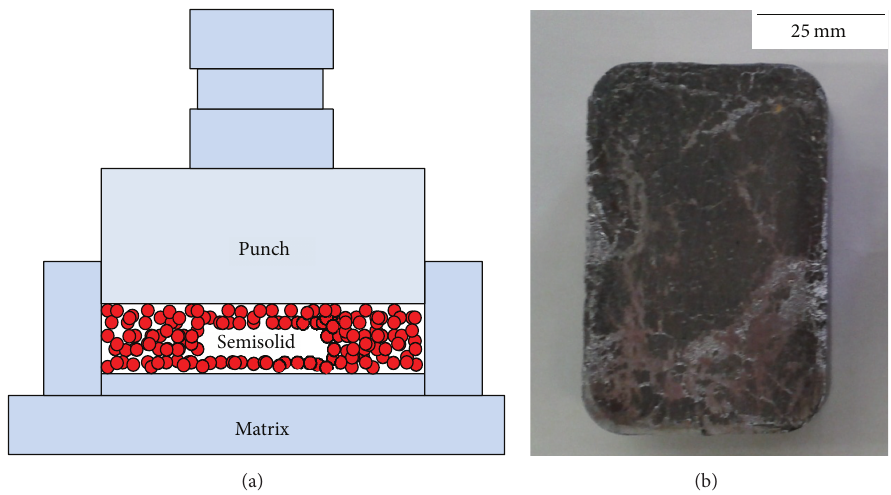
Figure 2: Schematic representation of the matrix used for the thixoforging process. (a) Assembly of the matrix. (b) Thixoforged